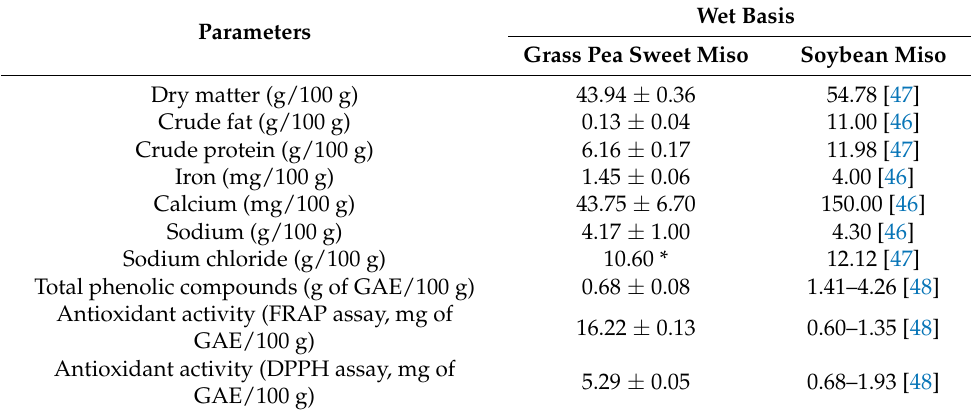
Table 3. Chemical composition and bioactivities of grass pea sweet miso and of traditional soy- bean miso. Wet Basis Parameters Grass Pea Sweet Miso Soybean